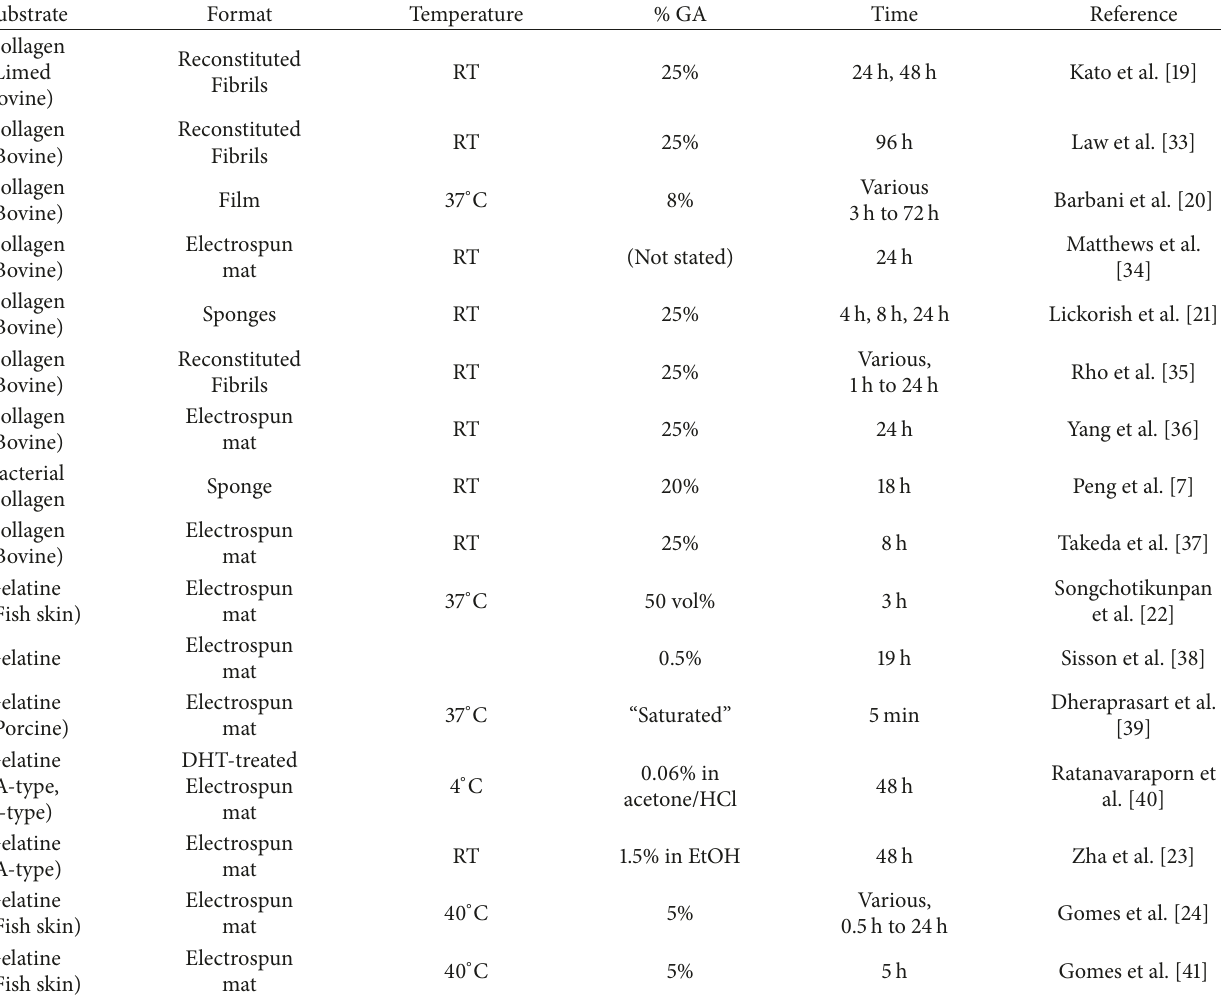
Table 1: Examples of previously reported conditions for GA vapour stabilisation of collagen and gelatine materials.